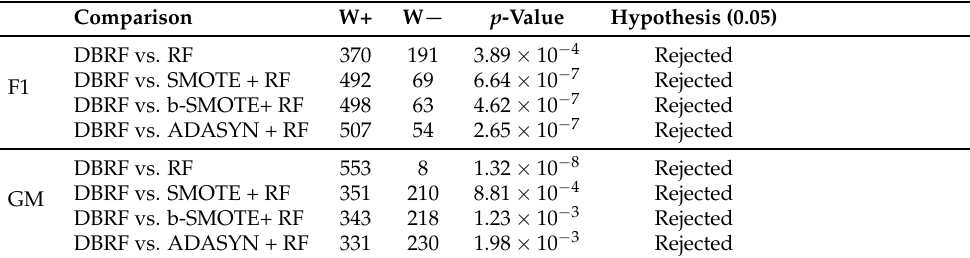
Table 5. Results of the Wilcoxon signed-rank test for F1 and GM of 34 datasets. W+ represents the positive differential rank sum. W − represents the negative differential rank